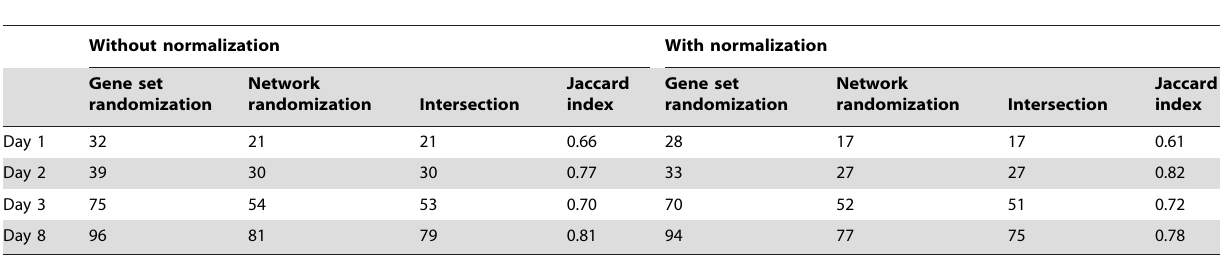
Table 3. Comparison of the properties of the CBPLNs computed by using each hypothesis test.